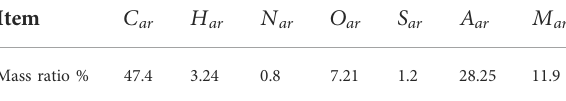
TABLE 1 Coal elemental analysis of the TSACPG system.